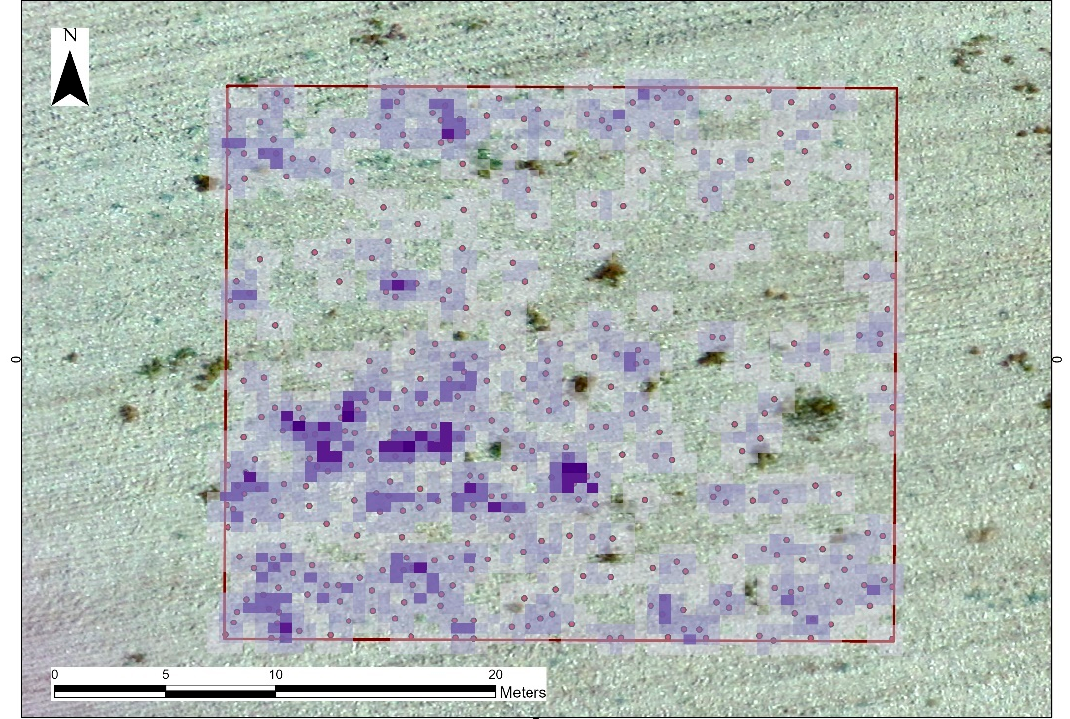
Figure 6. Potsherd distribution as estimated from the UAV orthomosaic in Area 20. A higher density is indicated in dark purple.